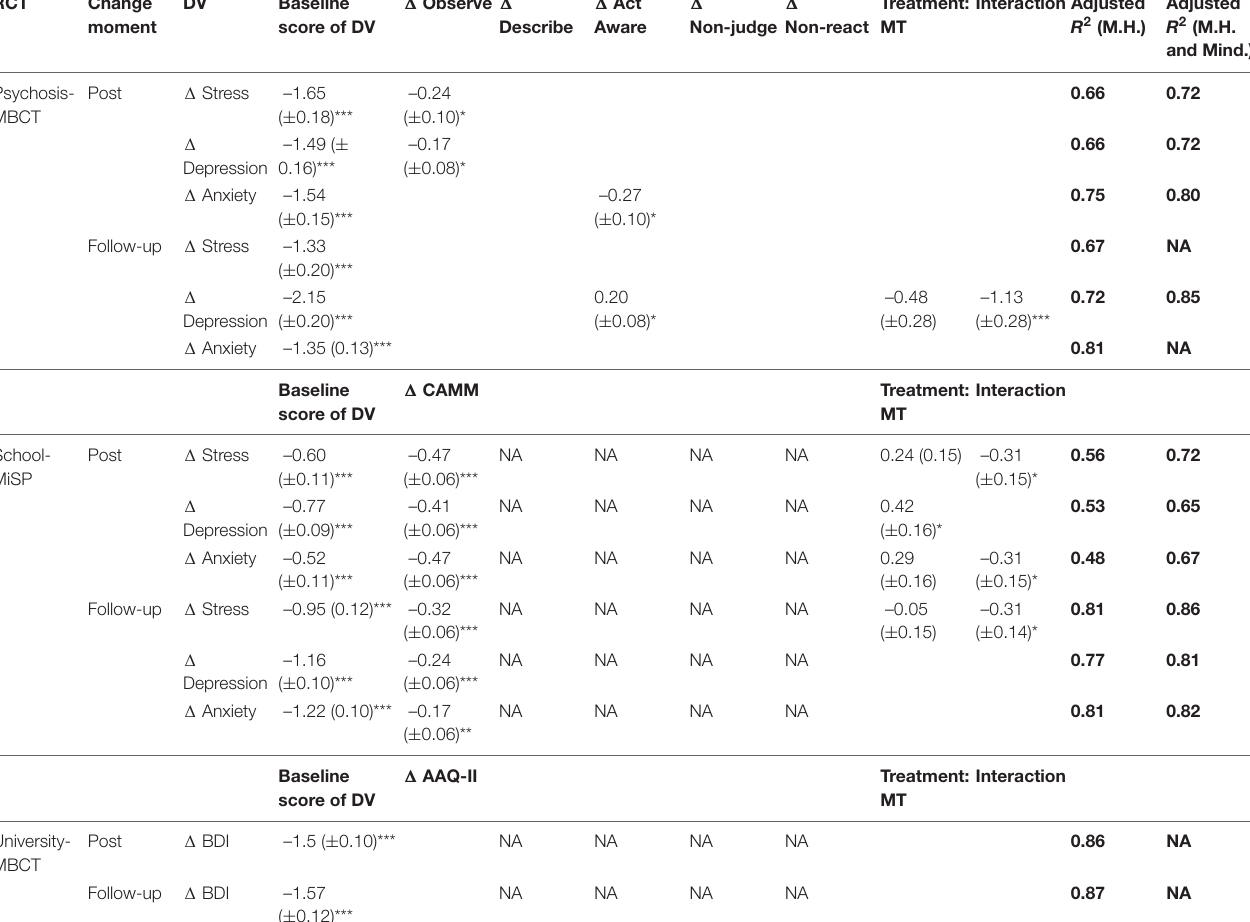
TABLE 4 | Summary of mental health multiple linear regression models. RCT Change DV Baseline moment score of DV